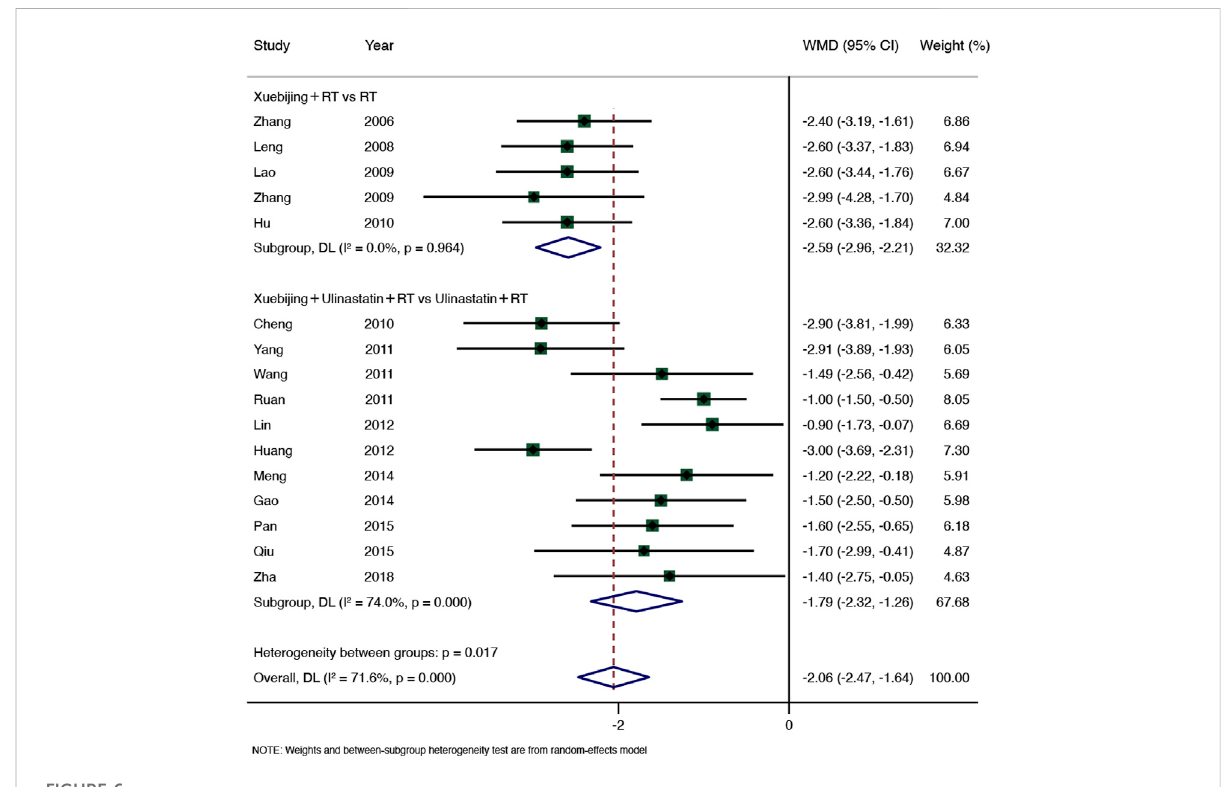
FIGURE 6 Meta-analysis of serum amylase